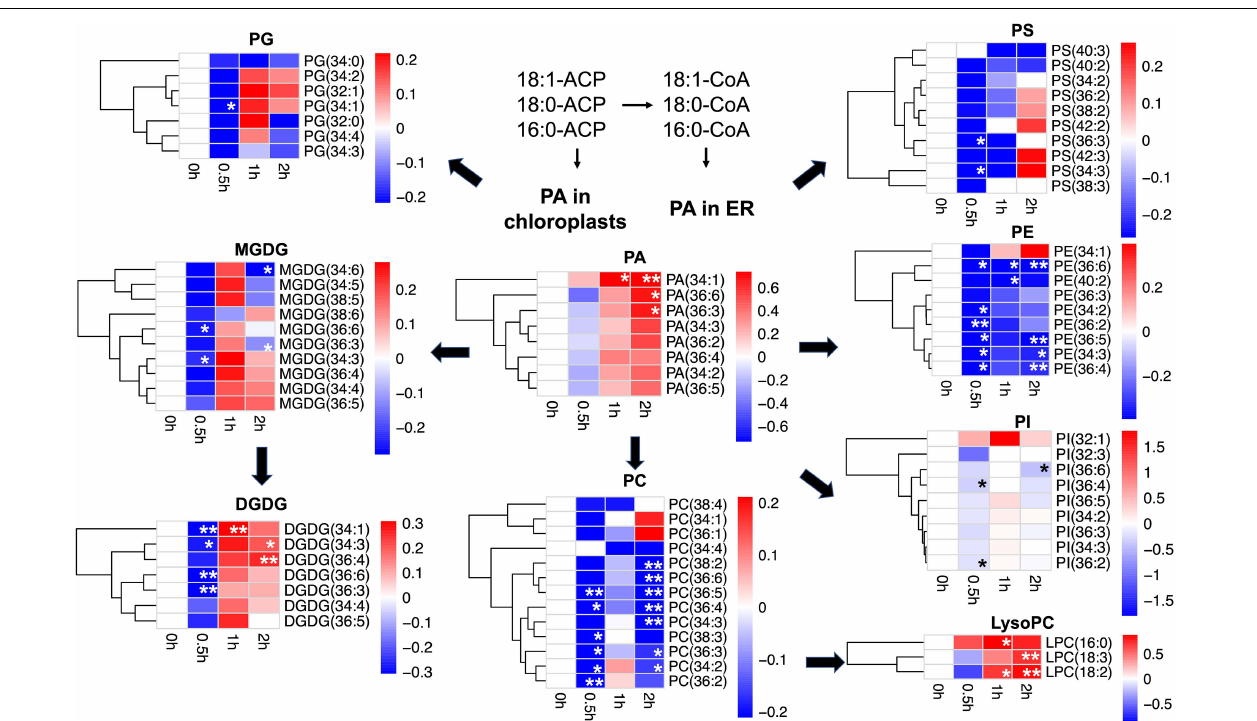
FIGURE 1 | Changes in lipid acyl species under salt stress in leaves of soybean ( Glycine max [L.] Merr.) accession C08. Heatmaps showing the log 2 -fold changes in each affected lipid acyl species at 0.5, 1, and 2 h of salt treatment. PA as lipid metabolic intermediates in the endoplasmic reticulum (ER) are derived from 16:0, 18:0-ACP, and 18:1-ACP plastidial de novo fatty acid synthesis. Total lipids were extracted from leaves of 14-day-old C08 seedlings grown in 1/2 strength Hoagland solution and treated with or without 0.9% (w/v) NaCl. The lipid molecular species were quantified by tandem mass spectrometry. Scale bar represents log 2 -fold changes. *, significant difference at p ≤ 0.05; **, significant difference at p ≤ 0.01 using the Student’s t -test. The raw data is provided in Supplementary Table 1 . ACP, acyl carrier protein; DGDG, digalactosyldiacylglycerol; LysoPC, lysophosphatidylcholine; MGDG, monogalactosyldiacylglycerol; PA, phosphatidic acid; PC, phosphatidylcholine; PE, phosphatidylethanolamine; PG, phosphatidylglycerol; PI, phosphatidylinositol; PS,